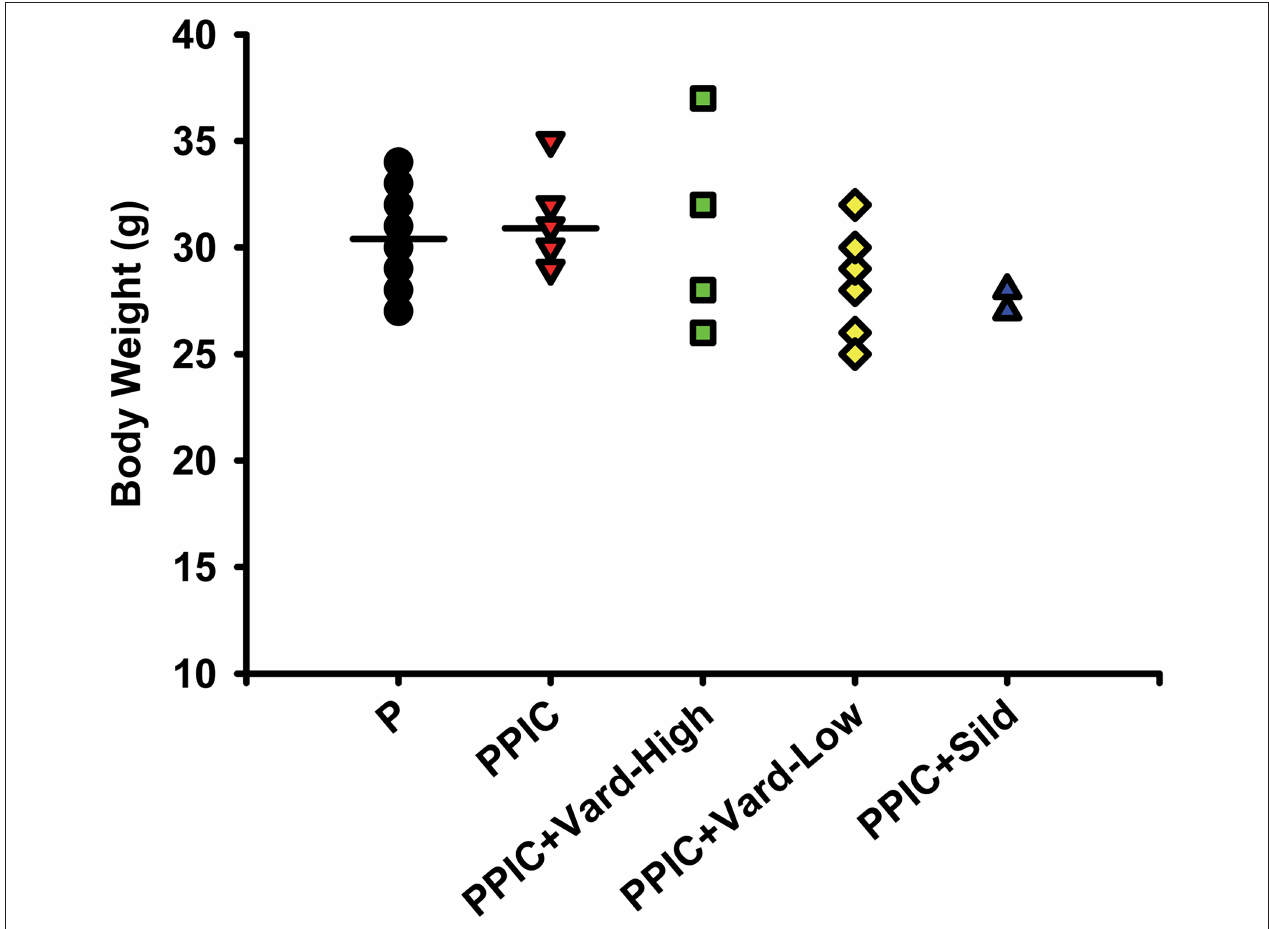
FIGURE 2 | Body weight measures of control pregnant (P) mice ( n = 10), P mice treated with the TLR3 agonist and viral mimetic poly I:C (PPIC) ( n = 10), PPIC mice treated with a high dose ( n = 6) and low dose ( n = 6) of vardenafil (Vard), and PPIC mice treated with sildenafil (Sild) ( n = 6).